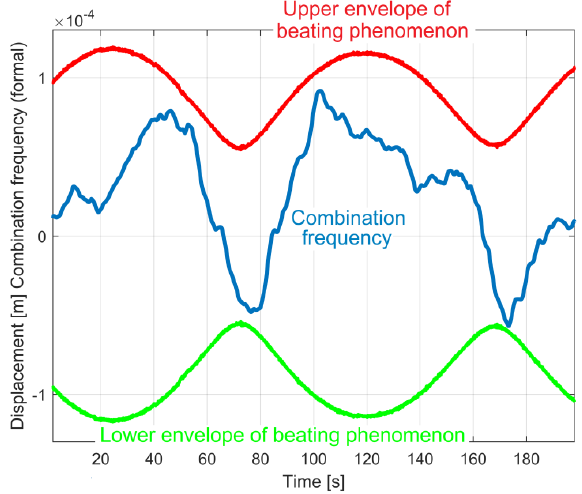
Figure 13. Low-pass filtered rotational frequency evolution of the main spindle and supplying voltage frequency evolution of the driving motor.